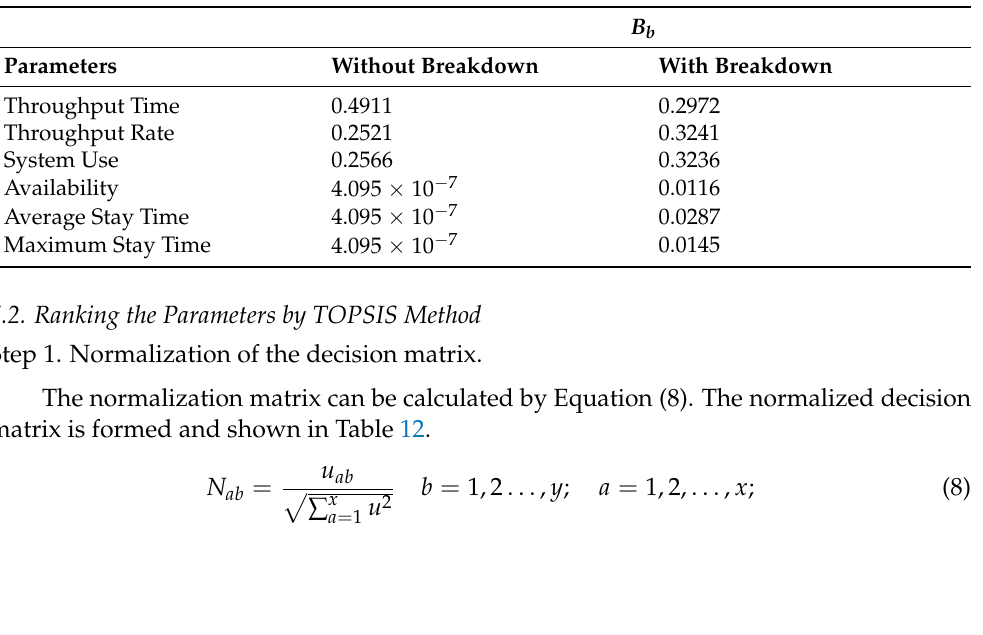
Table 11. Weights of all criteria.